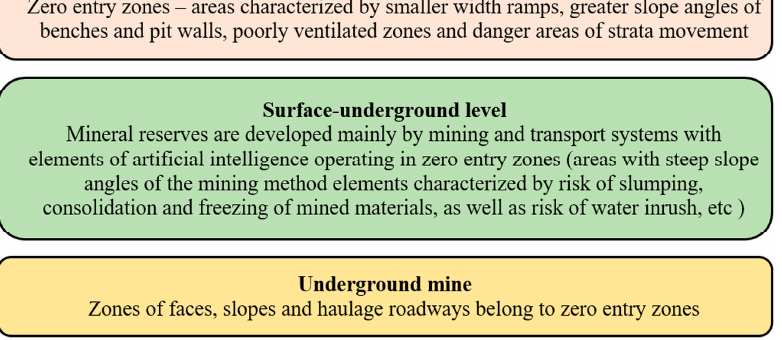
Figure 22. Zoning of unmanned mining technologies in underground and surface (Reprinted from Ref.